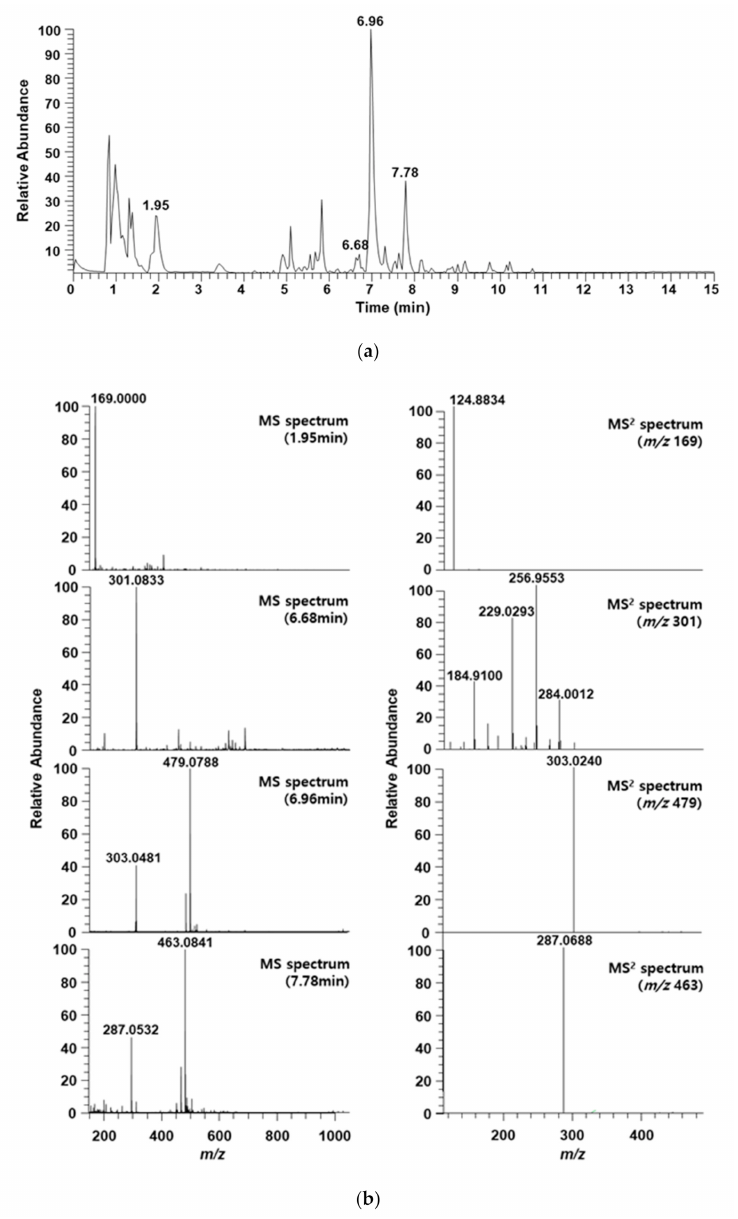
Figure 3. Ultra high-performance liquid chromatography–mass spectrometry (UHPLC-MS) chro- matogram of OBS-E. ( a ) Total ion chromatogram. ( b ) MS and MS 2 spectra of the peaks at 1.95 min, 6.68 min, 6.96 min, and 7.78 min on the total ion chromatogram. OBS-E was applied to the UHPLC system at a 10 mg/mL